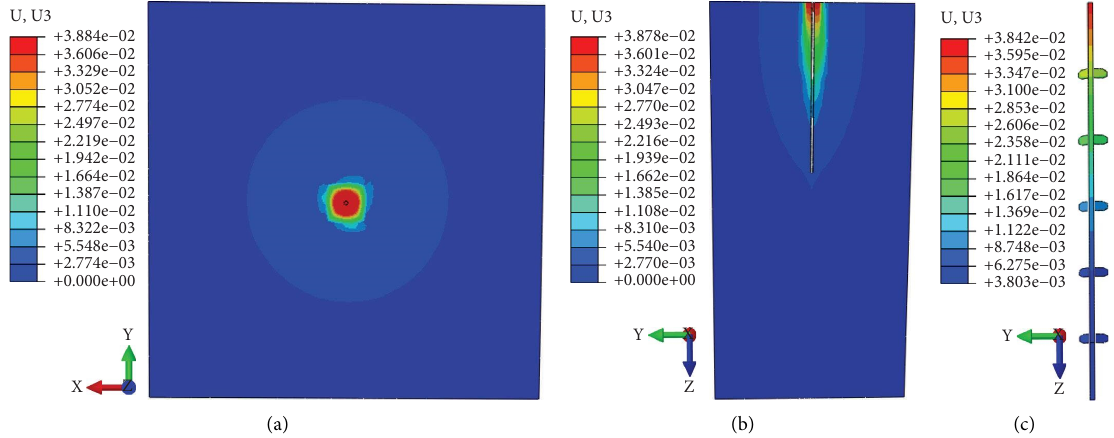
Figure 16: Composite Foundation Displacement: (a) top displacement; (b) vertical section; (c) pile displacement.